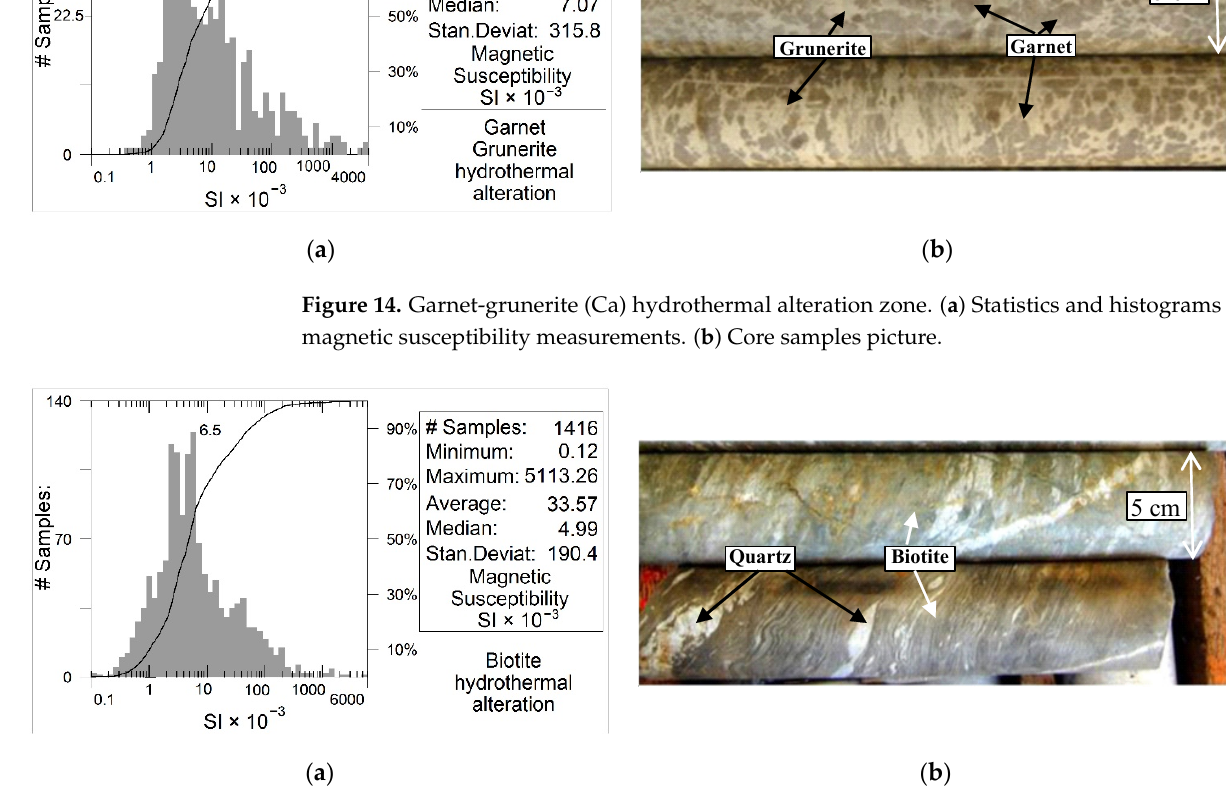
Figure 15. Potassic (K) hydrothermal alteration zone. ( a ) Statistics and histograms of the magnetic susceptibility measurements. ( b ) Core samples picture.